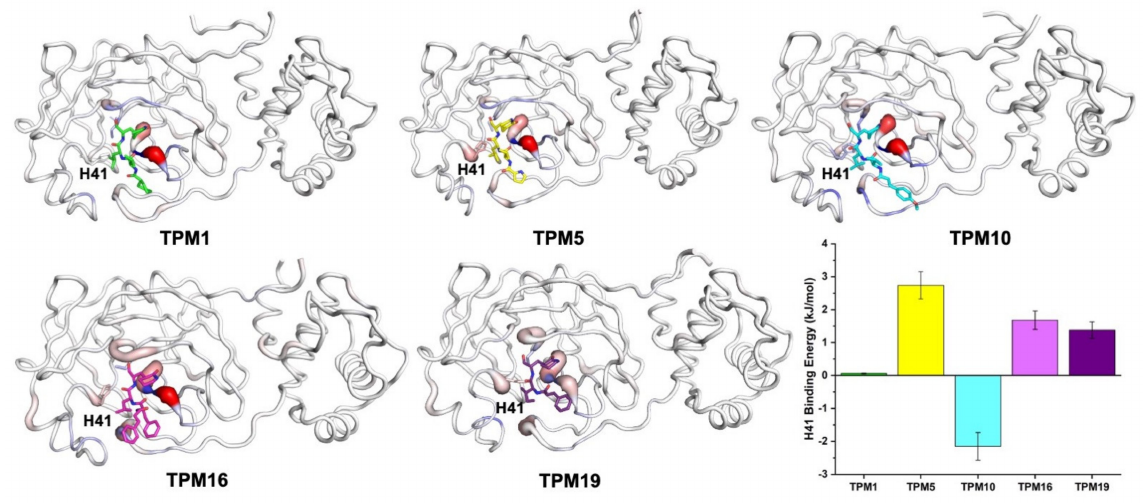
Figure 4. The interactions between TPMs and surrounding residues. The distribution of ∆ G bind on the 3CL Pro residues are illustrated with grey ( ∆ G bind ≈ 0), red ( ∆ G bind > 0), and blue ( ∆ G bind < 0) colors. The interaction energies between the H41 residue (shown as sticks) and TPMs are summarized as a histogram (average values of three independent trajectories, each of 1000